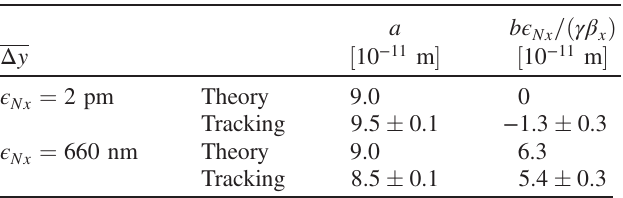
TABLE II. Coefficients from fitting tracking results and theory Eq. (13): y 0 0 in ½ 10 − 5 rad (cid:3) units. Δ y